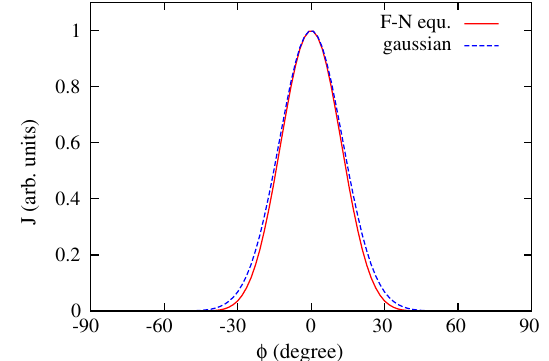
FIG. 2. Temporal distribution of field emission with the current density normalized for comparison. A material of copper is supposed and the peak emission density is 100 A = cm 2 . The resulted rms width is 12.9 (cid:2) .